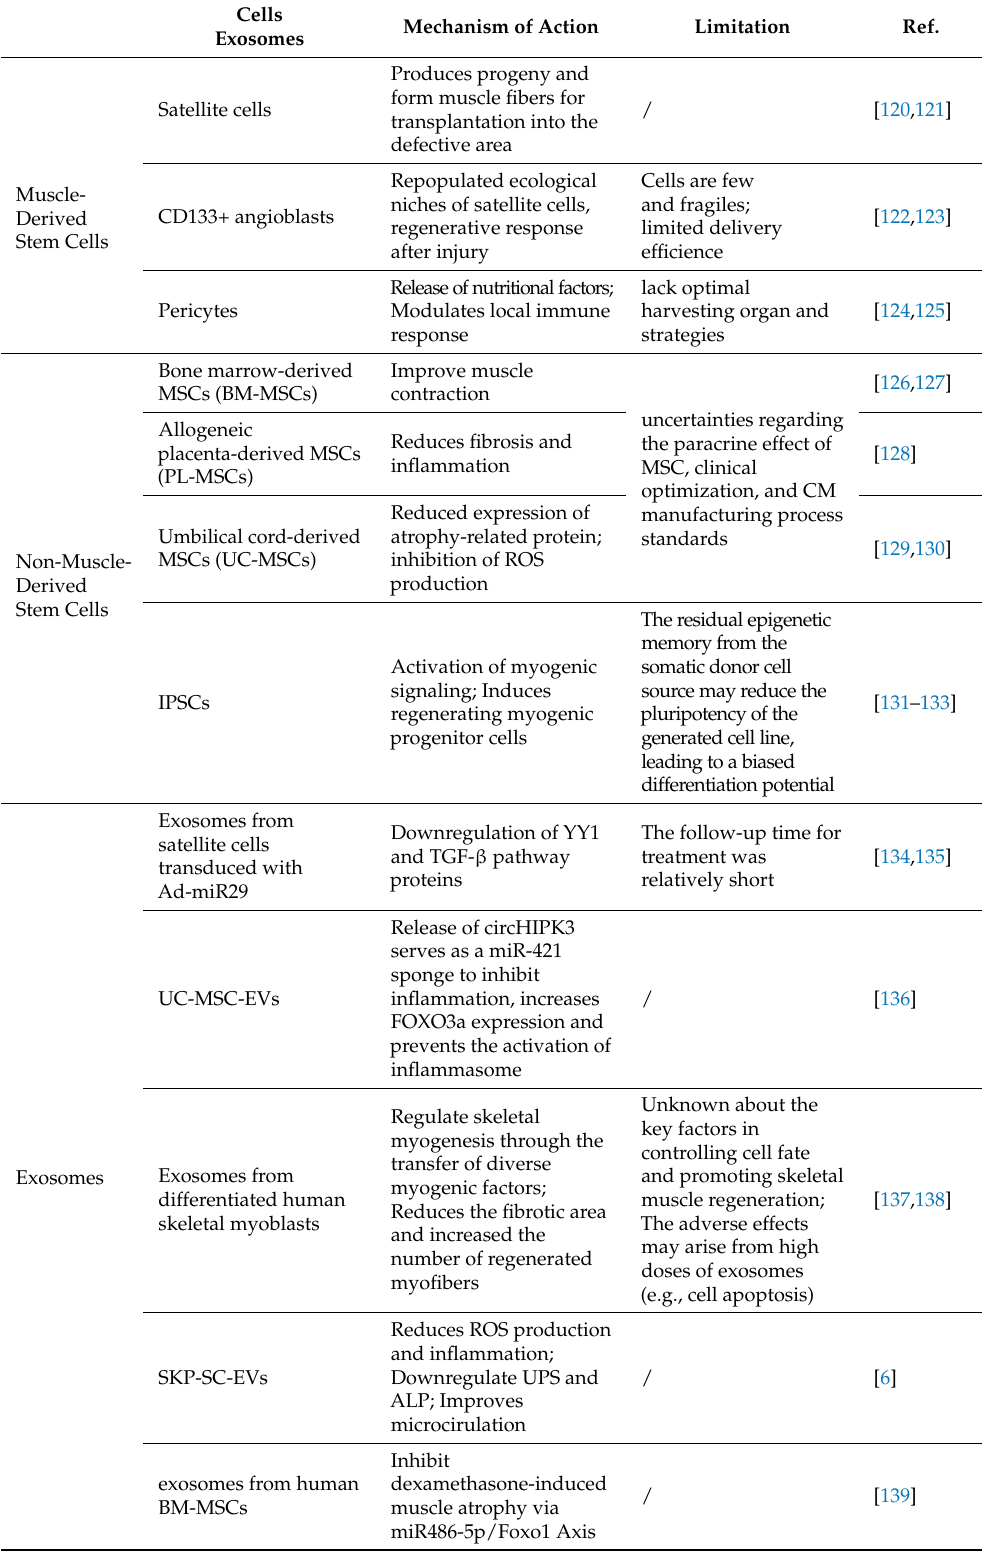
Table 2. Stem Cell and Exosome Therapy for skeletal muscle